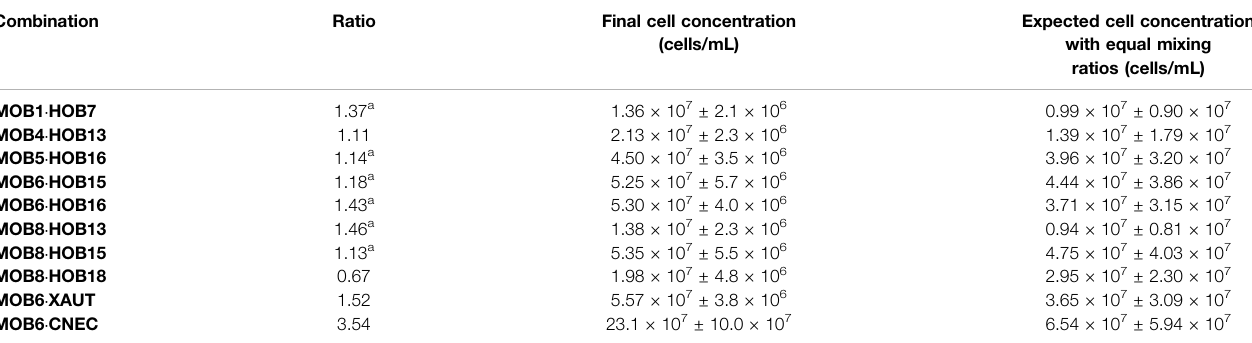
TABLE 4 | Expected and observed cell densities of the combinations and their ratio.